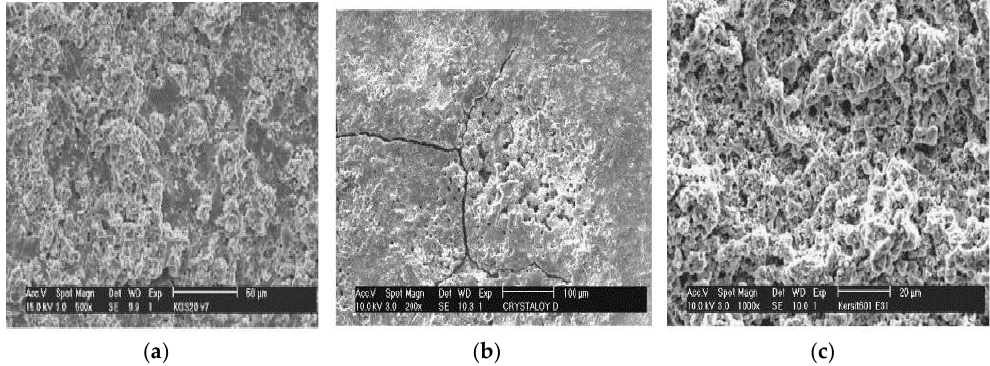
Figure 10. ( a ) Topography of ZrO 2 – TiN by wire EDM (V = 120 V, pulse on = 2.4 µs, pulse off = 15 µs); ( b ) Topography of Al 2 O 3 – SiCW – TiC by die sinking EDM in oil (high energy) (V = 250 V, i = 72 a, pulse on = 7.5 µs, pulse off = 18 µs); ( c ) Topography of Si 3 N 4 – TiN by Wire EDM (V = 160 V, pulse on = 2.8 µs, pulse off = 2.3 µs). (Reproduced with permission from [84]).